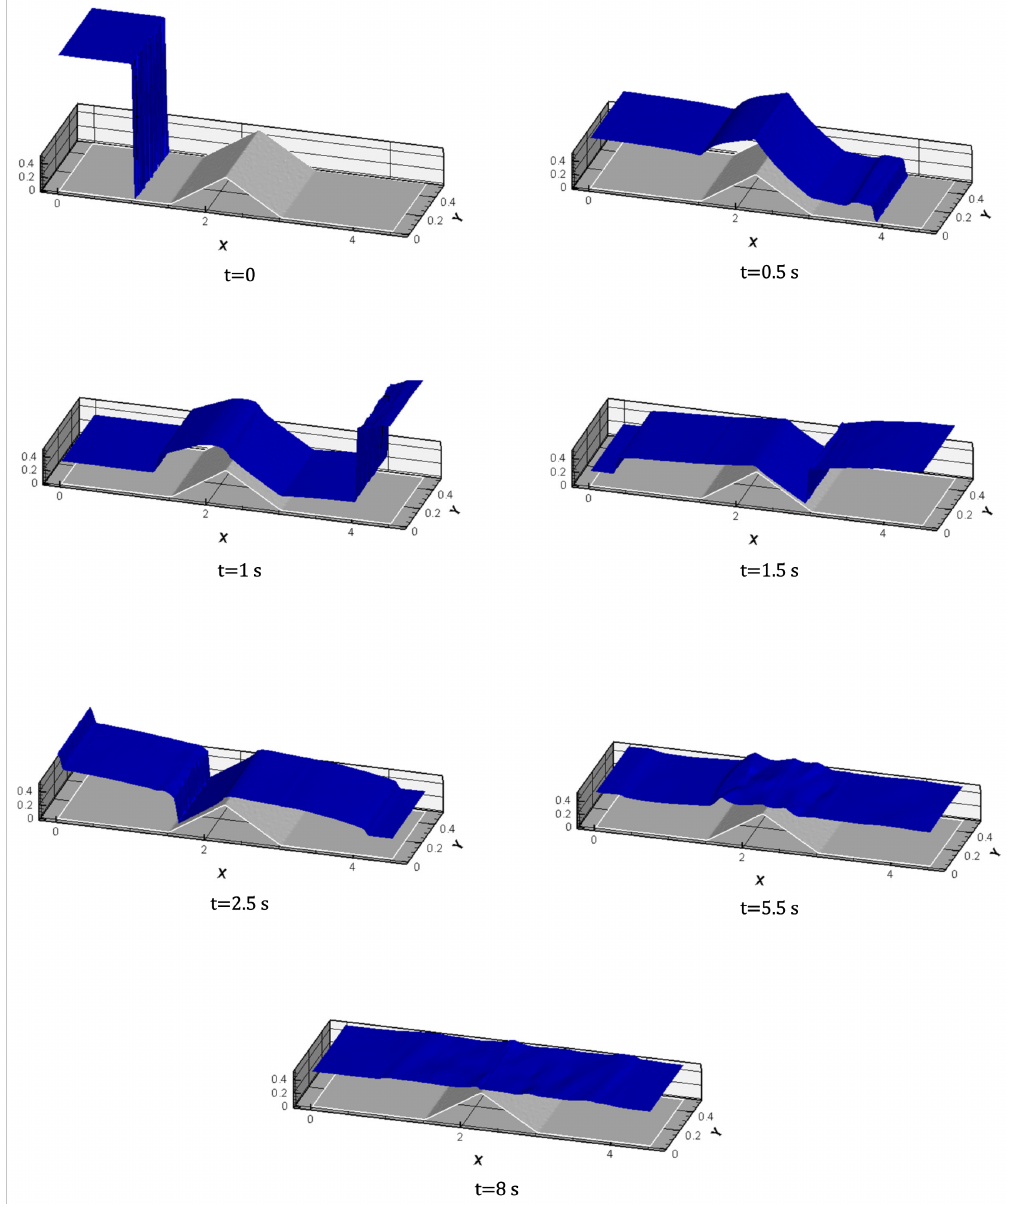
Figure 10. Progress of a wave in the test of flow passing the barrier and stability above the barrier level.